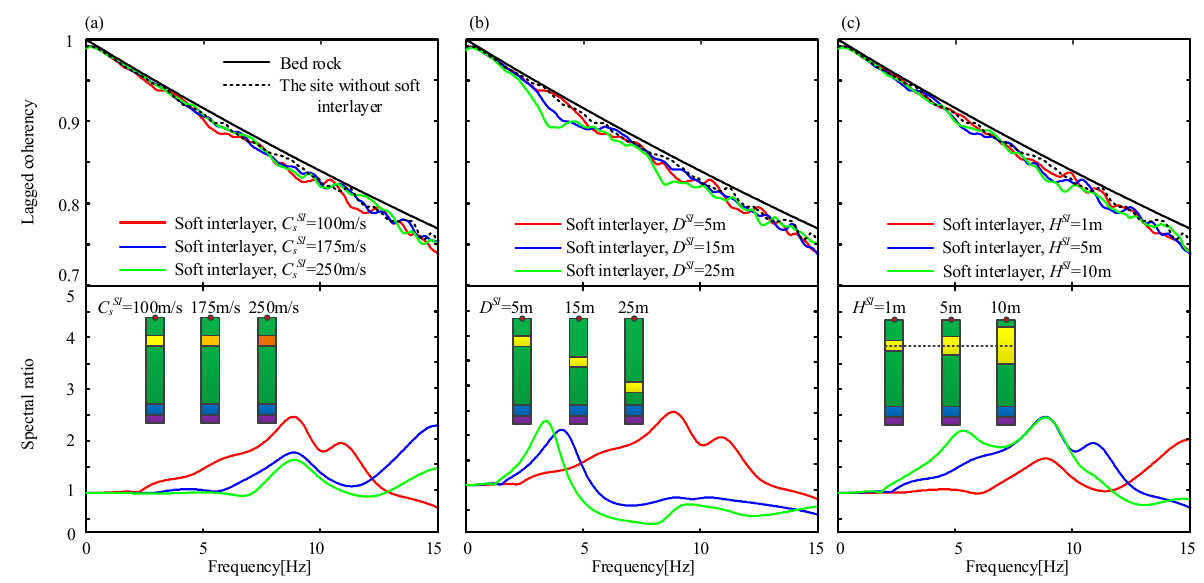
Figure 6. Mean lagged coherency between vertical in-plane motions and corresponding spectral ratios for varying ( a ) shear wave velocity; ( b ) buried depth; and ( c ) thickness of interlayer.